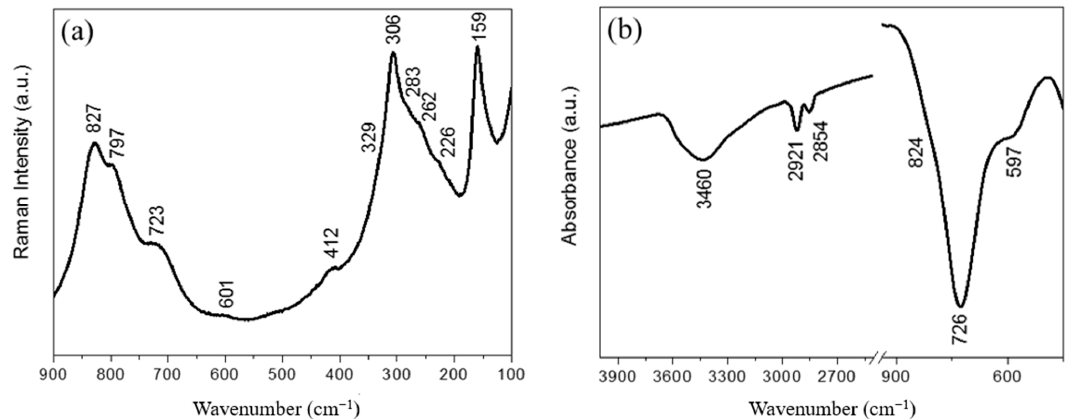
Figure 5. ( a ) Raman and ( b ) FTIR spectra of layered Bi 2 WO 6 nanosheets at room temperature. Table 1. Observed Raman and FTIR modes of layered Bi 2 WO 6 nanosheets.